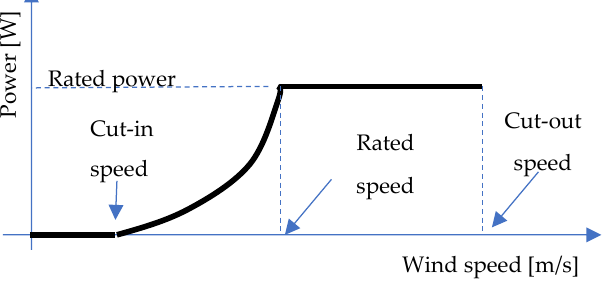
Figure 10. Typical wind power versus wind speed curve.